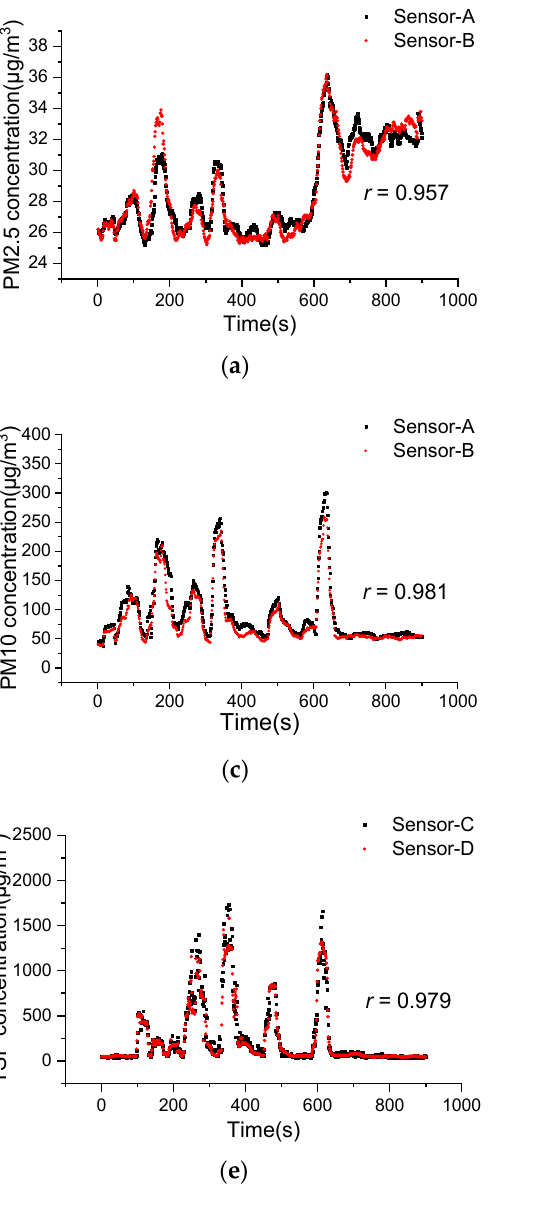
Figure 15. Sensor consistency and calibration results: ( a ) PM2.5 measurement consistency; ( b ) Sensor-A PM2.5 measurement calibration; ( c ) PM10 measurement consistency; ( d ) Sensor-A PM10 measurement calibration; ( e ) TSP measurement consistency; ( f ) Sensor-C TSP measurement calibration.